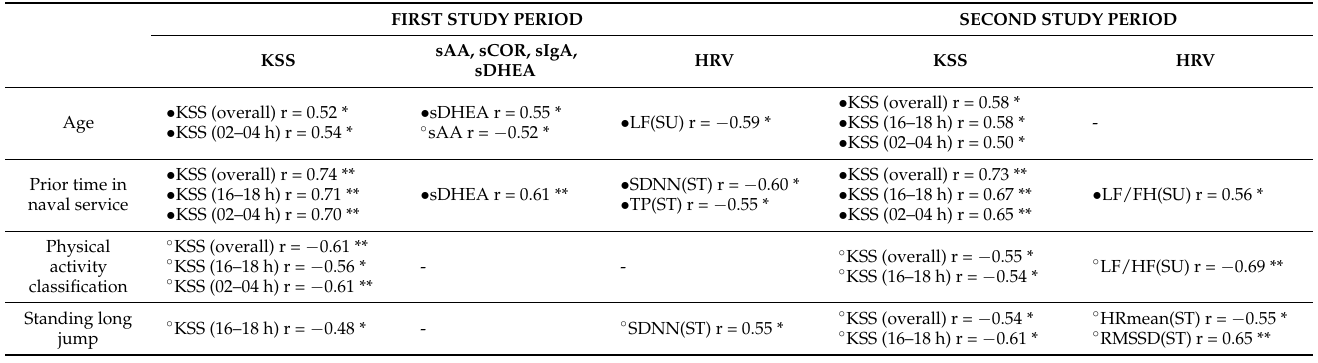
Table 2. Statistically significant correlations regarding the most distinct individual